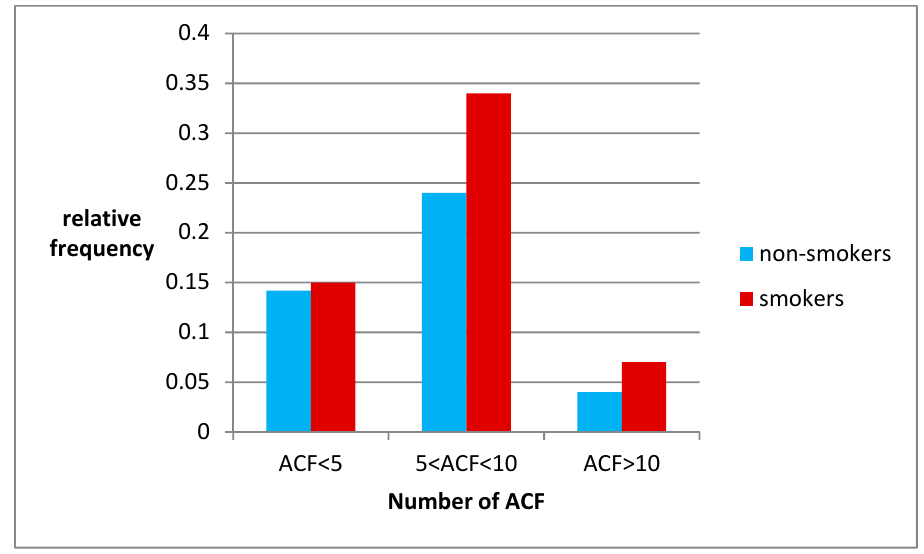
Figure 2. Relative probability of ACF number in the study group.